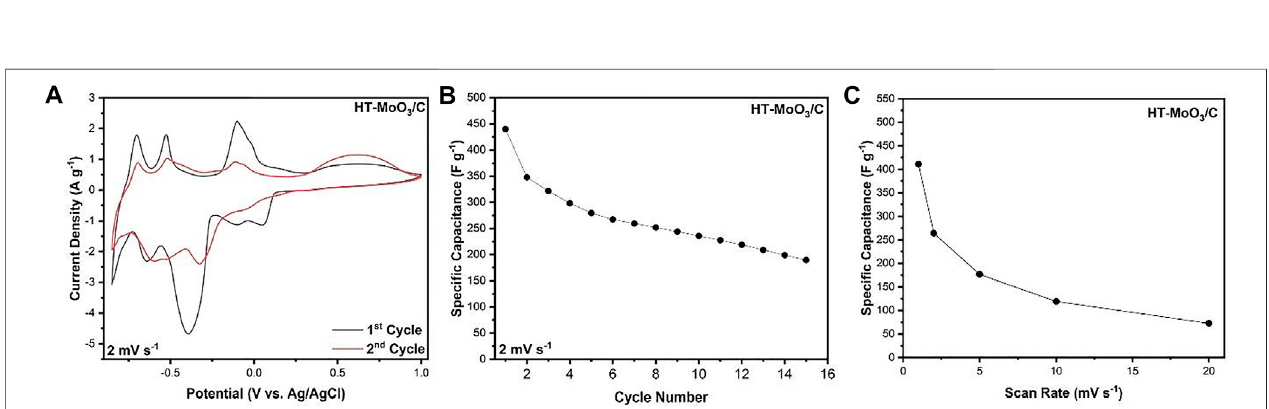
FIGURE8| ElectrochemicalchargestoragestudyofHT-MoO 3 /Cand α -MoO 3 -refelectrodesincellscontaining5MZnCl 2 aqueouselectrolyteinapotentialwindow from − 0.25 to 0.70 V: (A) second cycle CV curves, (B) cycling stability at a scan rate of 2 mV s − 1 , and (C) rate capability at increasing scan rates (1, 2, 5, 10, and 20 mV s − 1 ).